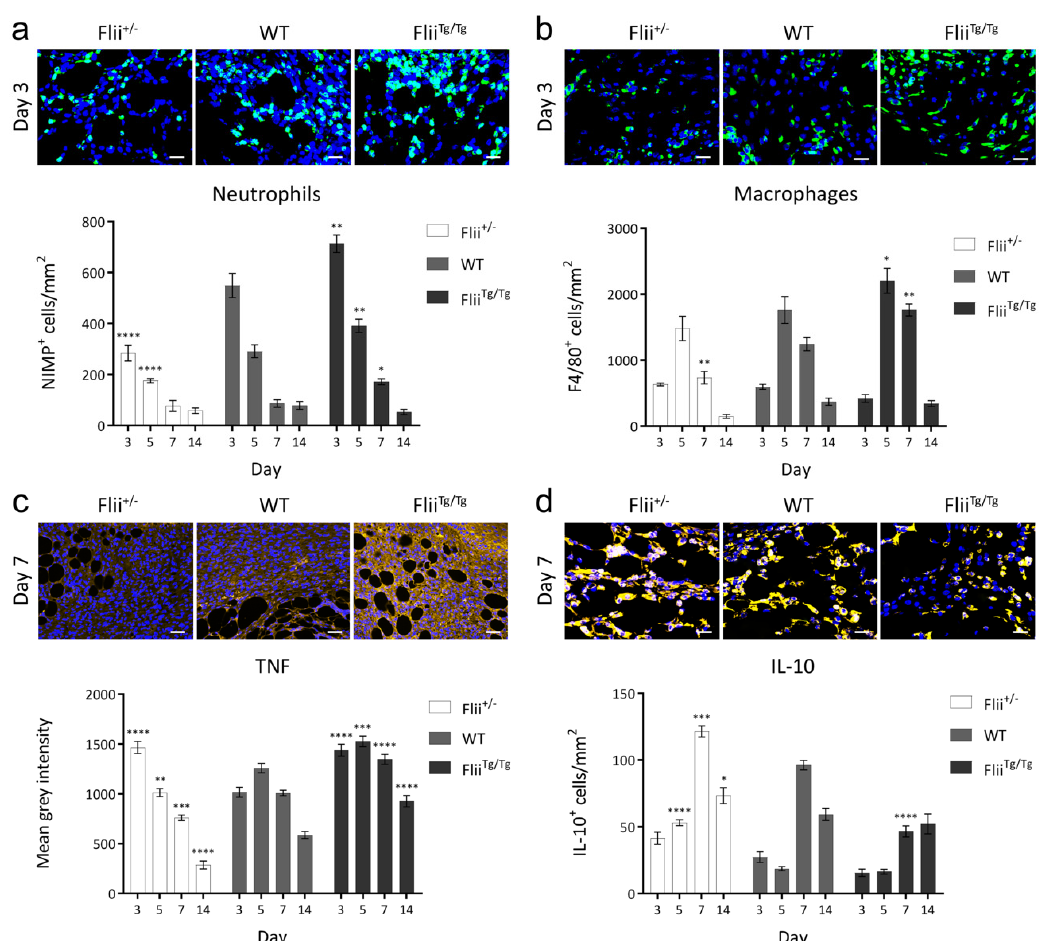
Figure 4. ( a ) Immunohistochemical detection and quantification of Anti-Neutrophil antibody